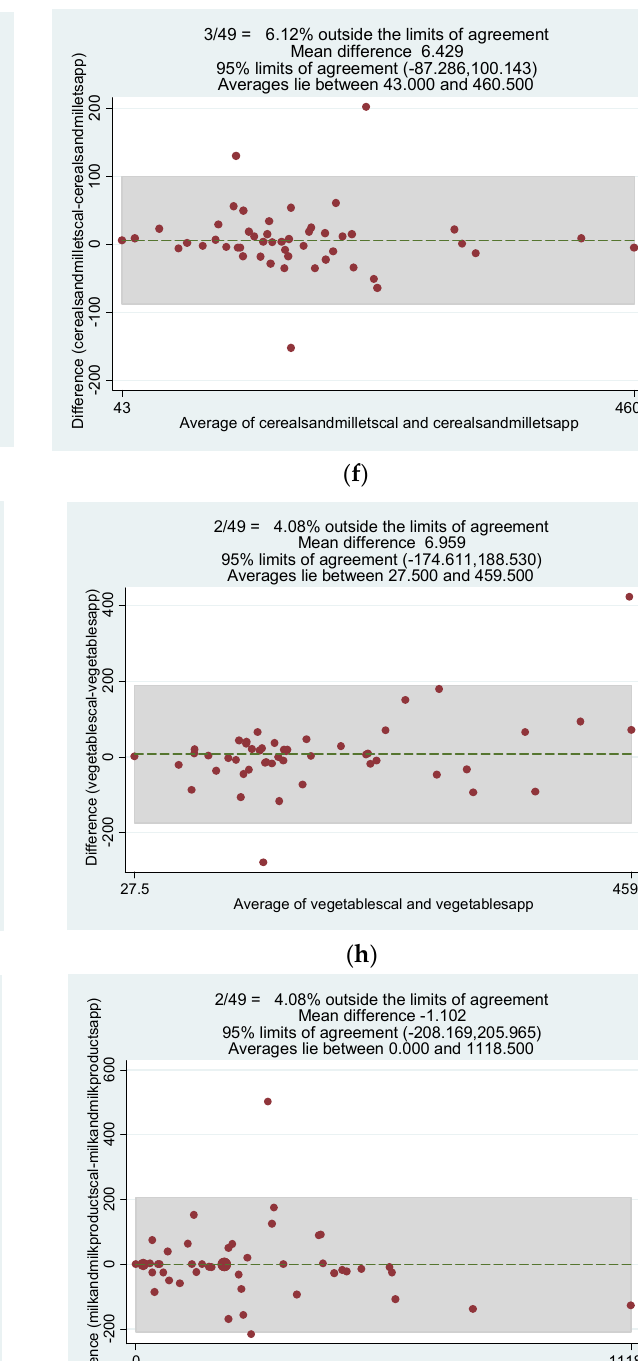
Average of milkandmilkproductscal and milkandmilkproductsapp